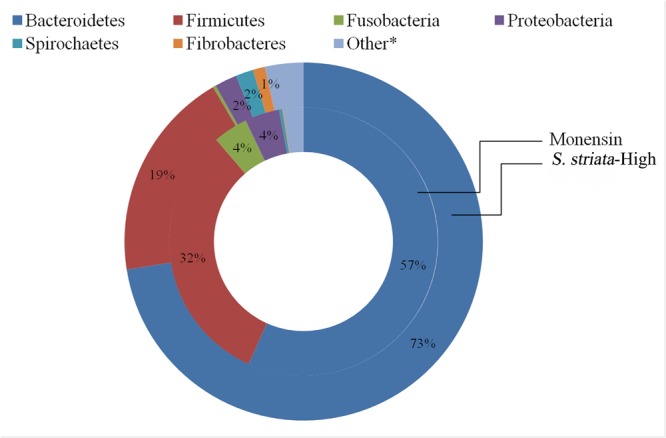
Comparison of the mean relative abundance of phyla between treatment groups supplemented with Scrophularia striata extract at 80 mg g-1 DM (S. striata-High) and those given monensin at 0.83 mg g-1 DM. Differences in the P-value for least square means between monensin and S. striata-High are Bacteroidetes (P < 0.001), Firmicutes (P < 0.001), Fusobacteria (P < 0.001), Proteobacteria (P = 0.001), Fibrobacteres (P = 0.001), Spirochaetes (P = 0.001). Other includes Lentisphaerae (P = 0.04), Planctomycetes (P = 0.001), Actinobacteria (P = 0.96), Chloroflexi (P = 0.65), Elusimicrobia (P = 0.99), Synergistetes (P = 0.69), Tenericutes (P = 0.37), TM7 (P = 0.99), WPS-2 (P = 0.28). ∗Individual phyla within the “Other” group do not have means which are significantly (P < 0.05).